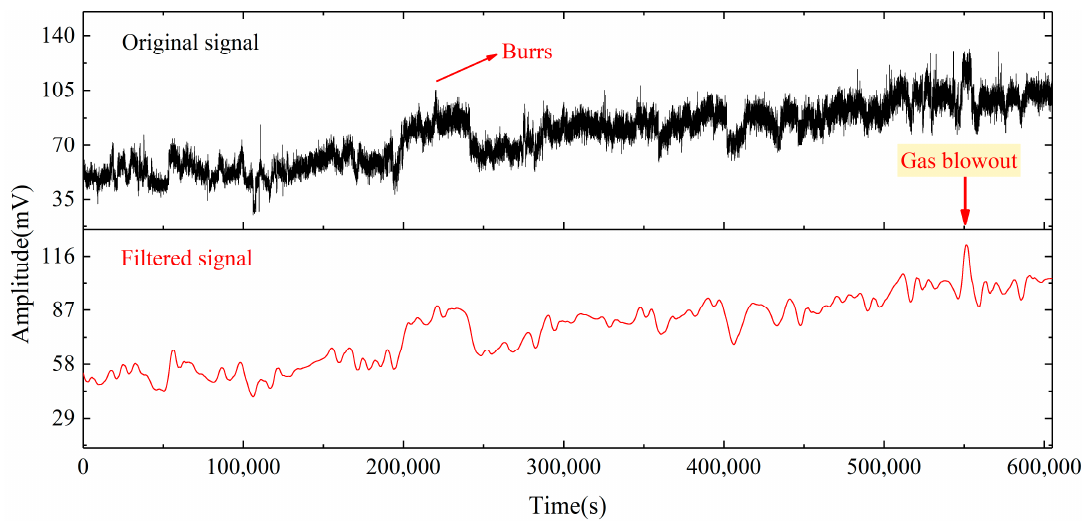
Figure 12. Comparison between the original signal and the filtered signal (EMR).